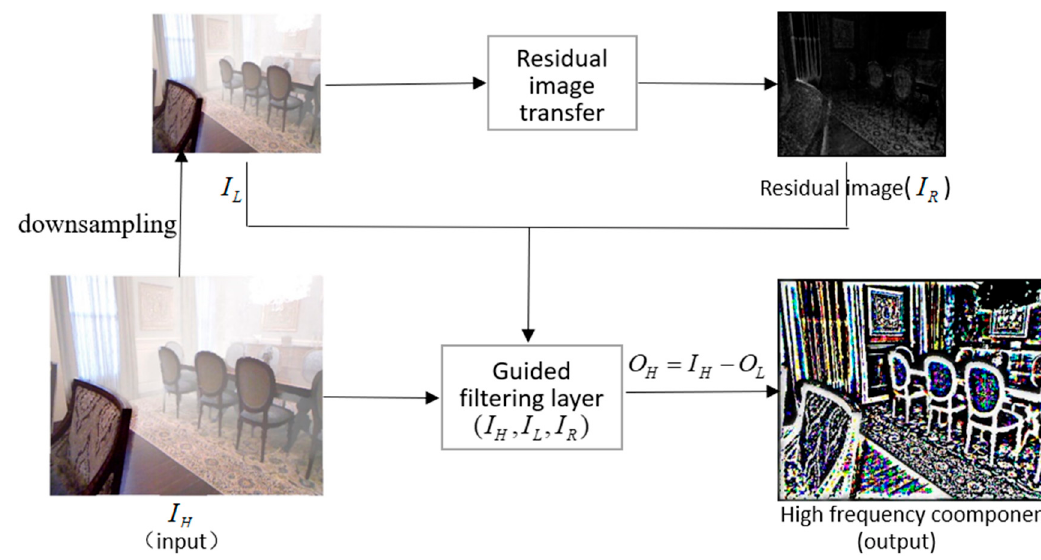
Figure 4. Intermediate results of the decomposition process.